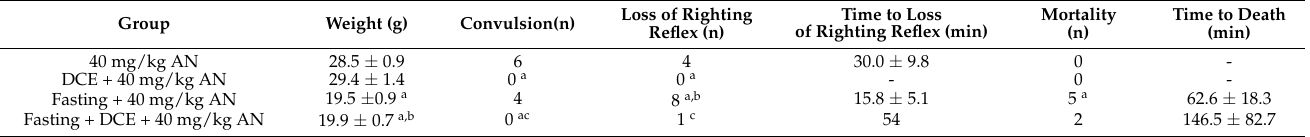
Table 2. Effects of fasting and DCE on acute toxicity in mice exposed to 40 mg/kg AN.